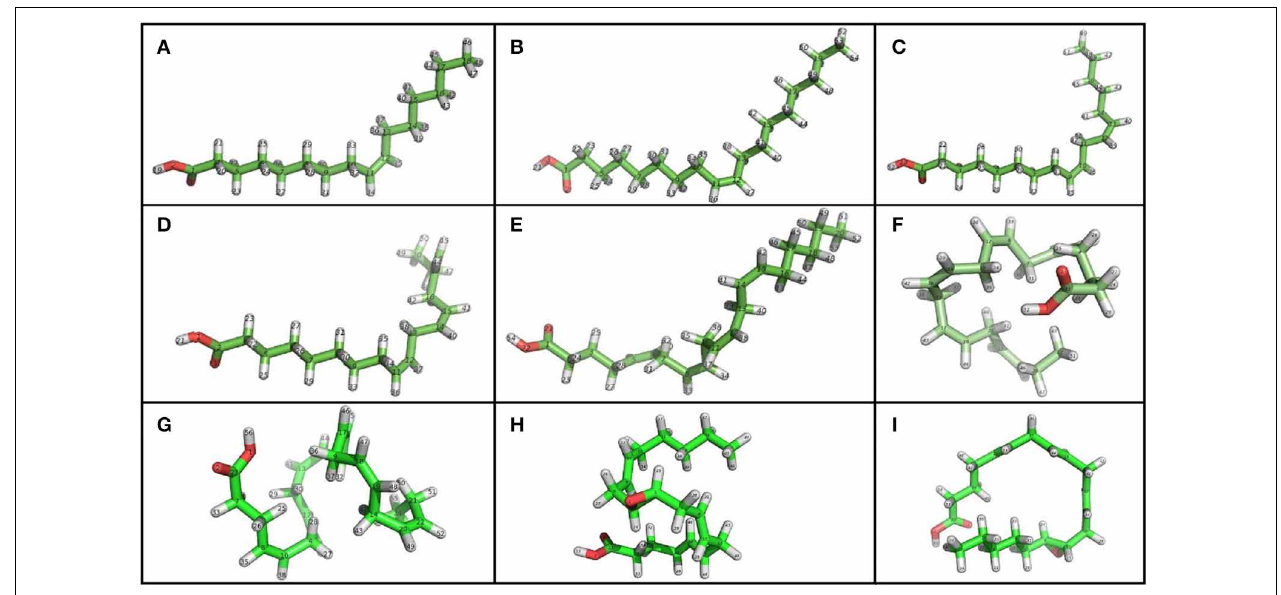
FIGURE 6 | Chemical structure of unsaturated fatty acids that modulate BK channel activity. (A) PAM, Palmitoleic Acid; (B) OA, Oleic Acid; (C) LA, Linoleic Acid; (D) ALA, Linolenic Acid; (E) AA, Arachidonic Acid; (F) EPA, Eicosapentaenoic Acid; (G) DHA, Docosahexaenoic acid;